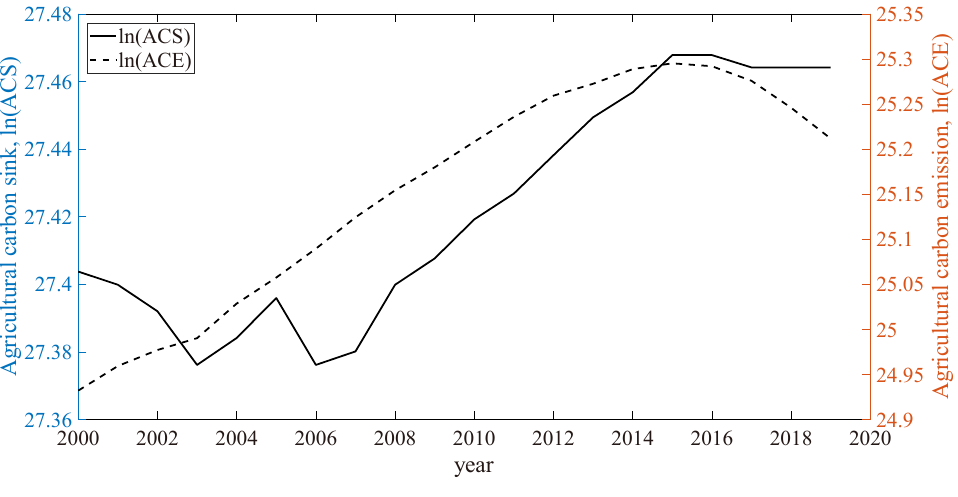
Figure 5. Time trends of the national ln(ACS) and ln(ACE) in China